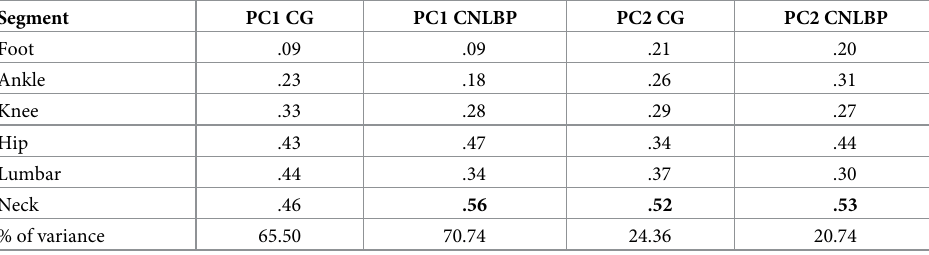
Table 2. Principal component analysis of the involved